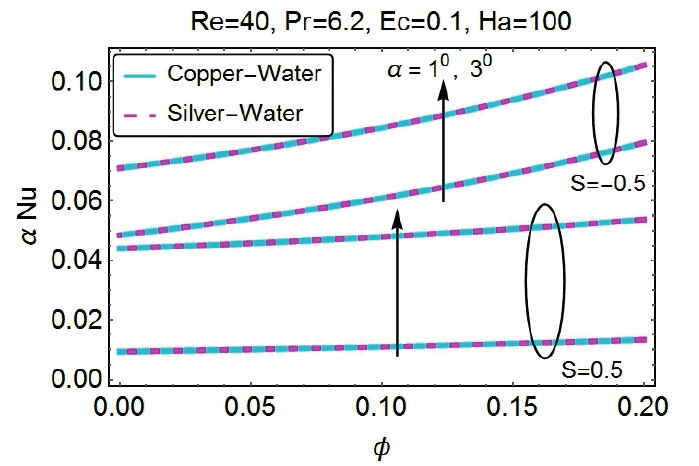
Figure 31. Variation in the skin friction coefficient with the Reynold number and the nanoparticle volume fraction (convergent channel).